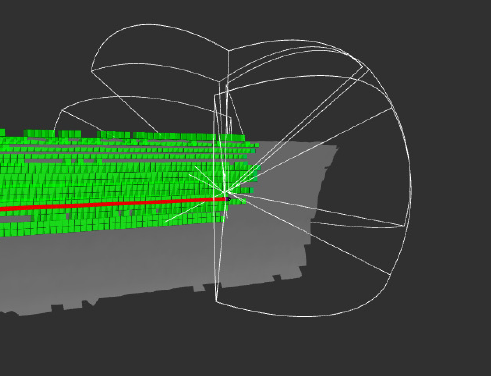
Figure 3. Visualization of the inspection sensors’ FOV , the voxels sensed by these sensors are marked in green and the explored tunnel wall in grey.